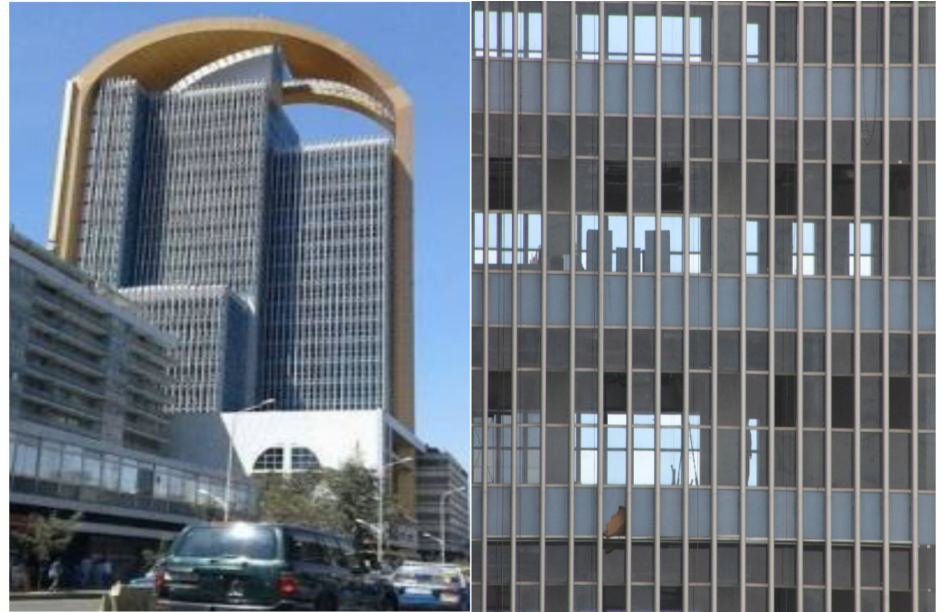
Figure 4. Solar shading technology used in the